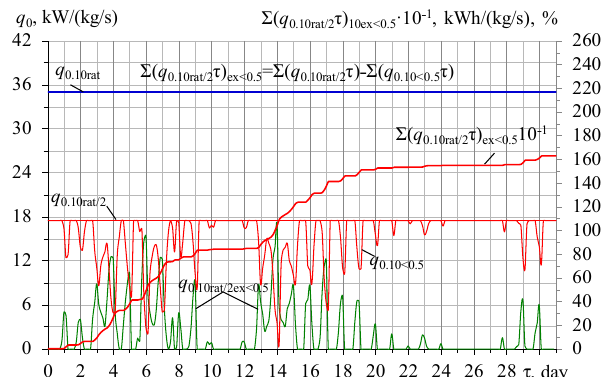
Figure 3. Actual values of refrigeration capacity consumption q 0.10 ˂ 0.5 and exceedance of rational refrigeration capacity q 0.10rat/2ex ˂ 0.5 within a range without regulation ( q 0.10 ˂ q 0.10rat/2 ), monthly summarized values of exceedance ∑ ( q 0.10rat/2 τ ) ex ˂ 0.5 : q 0.10rat/2ex ˂ 0.5 = q 0.10rat/2 − q 0.10 ˂ 0.5 ; ∑ ( q 0.10rat/2 τ ) ex ˂ 0.5 = ∑ ( q 0.10rat/2 τ − q 0.10 ˂ 0.5 τ ) ex ˂ 0.5 ; q 0.10rat/2 = 0.5 q 0.10rat ; q 0.10 ˂ 0.5 —marked for q 0.10 < 0.5 q 0.10rat .